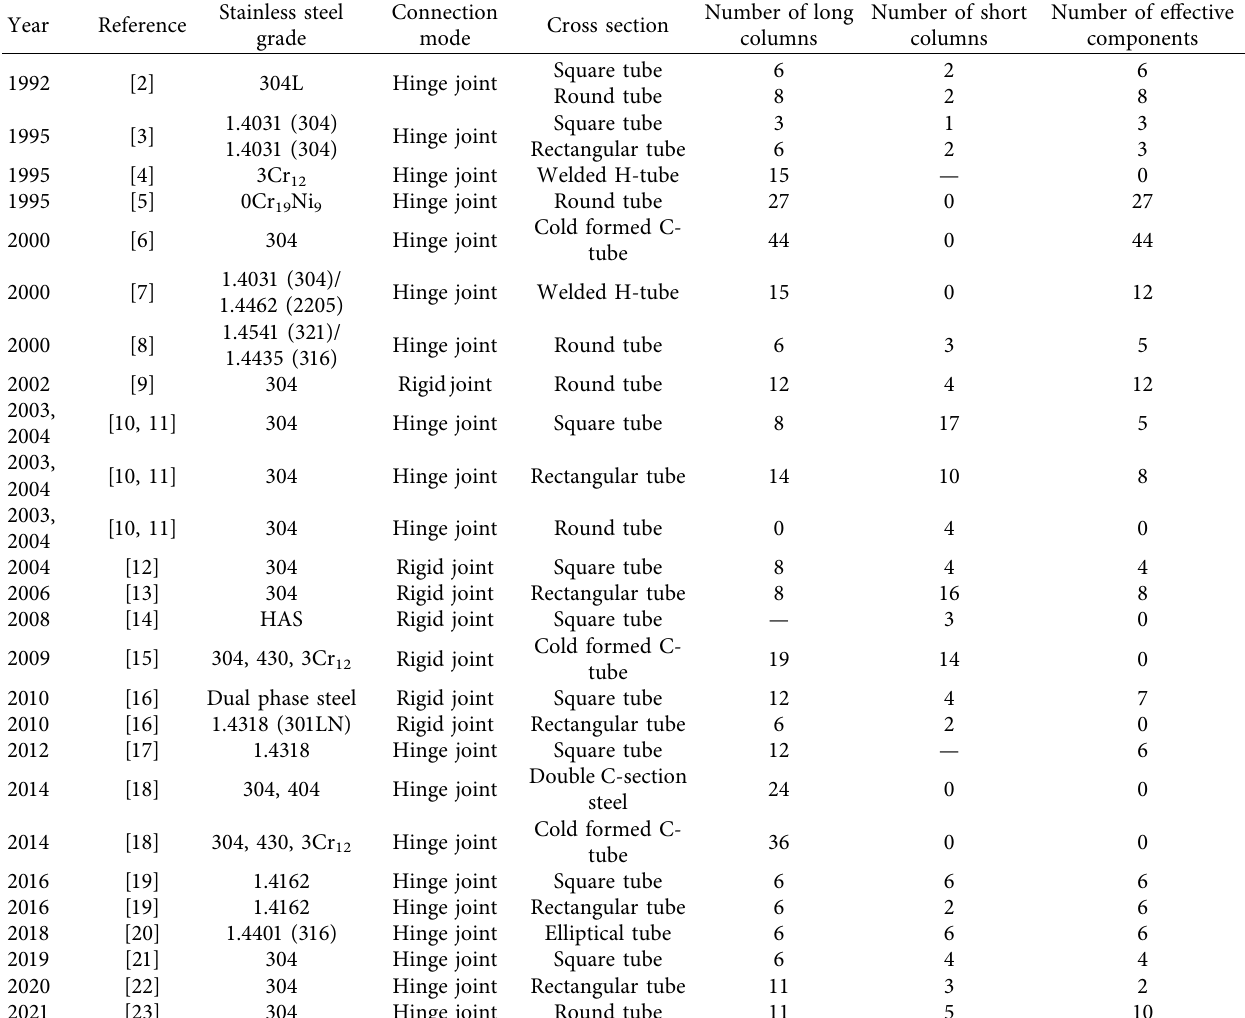
Table 1: Test data statistics of the stainless steel column.